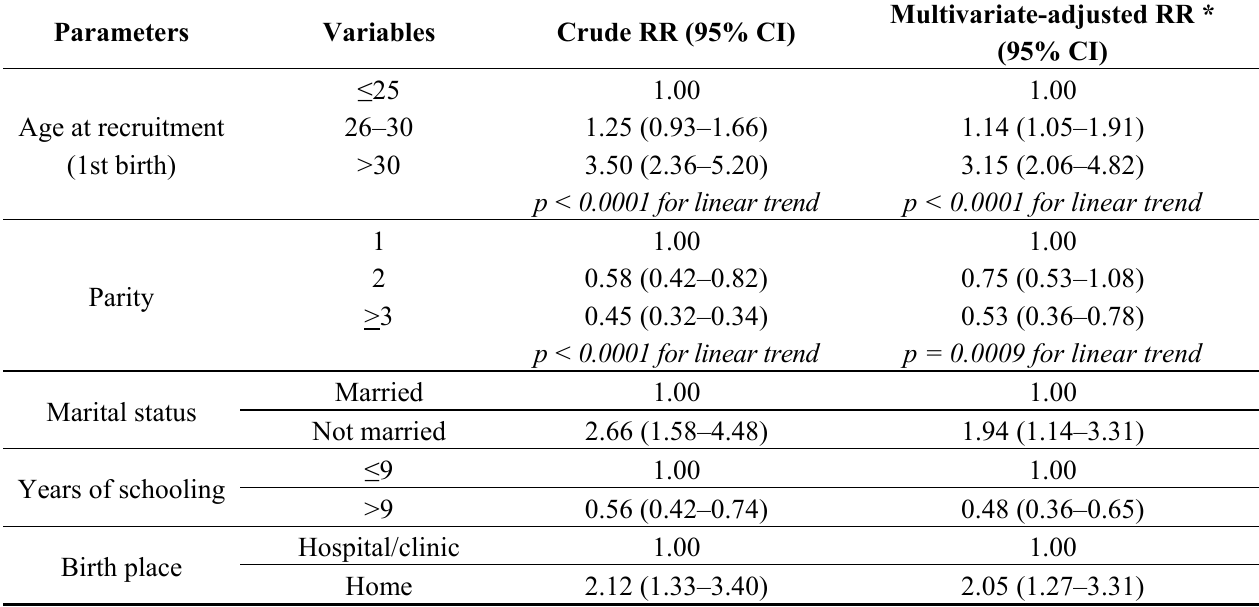
Table 2. Association between parity, age at first birth, and relative risk of death from asthma over a 32-year follow-up